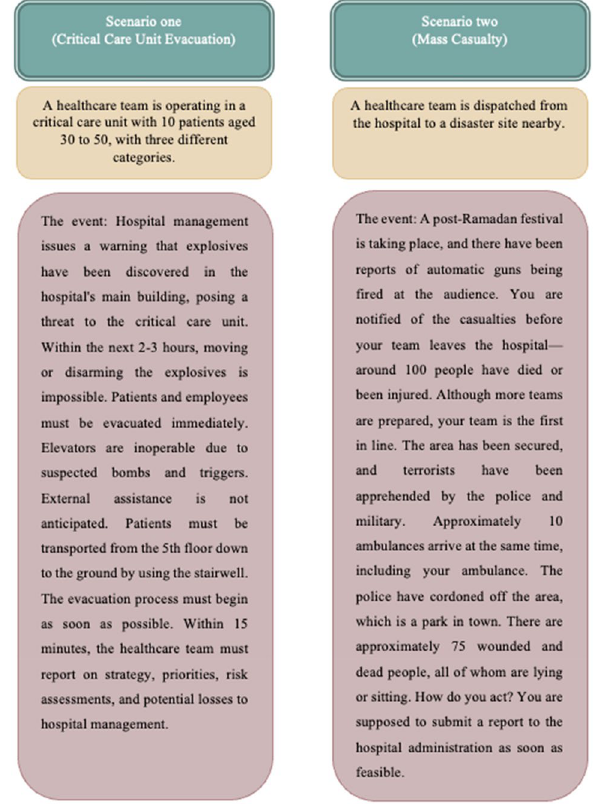
Fig. 1 The two scenarios adopted from realistic events within a hos- pital context for 3LC exercise courses in Najran, Saudi Arabia, in October and November